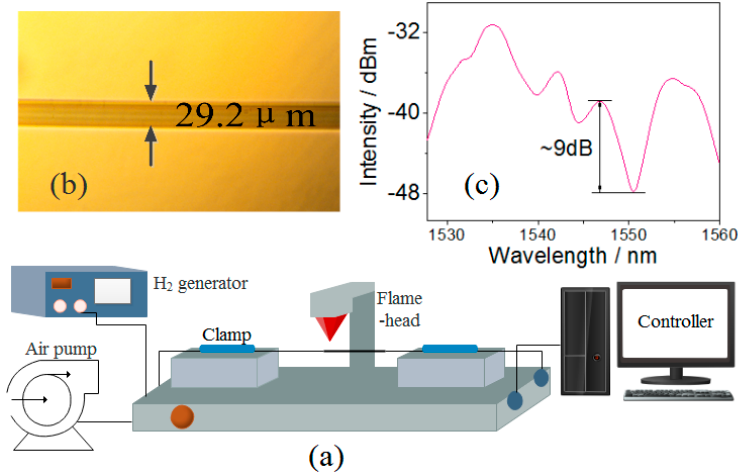
Figure 3. ( a ) Schematic diagram of fabrication of FT-SMS; ( b ) the CCD image of taper waist; ( c ) the transmission spectrum of FT-SMS.